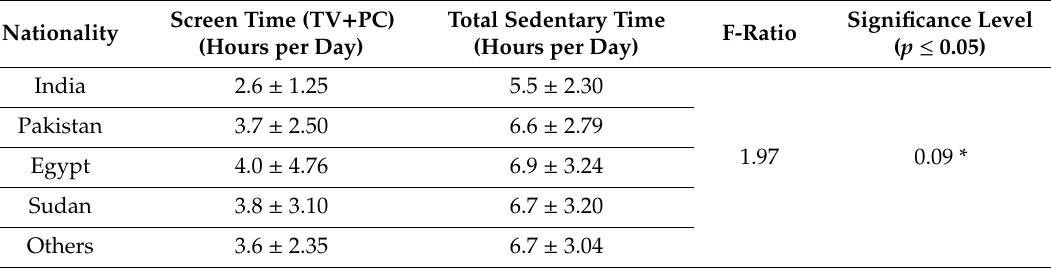
Table 2. Screen time and total sedentary time.